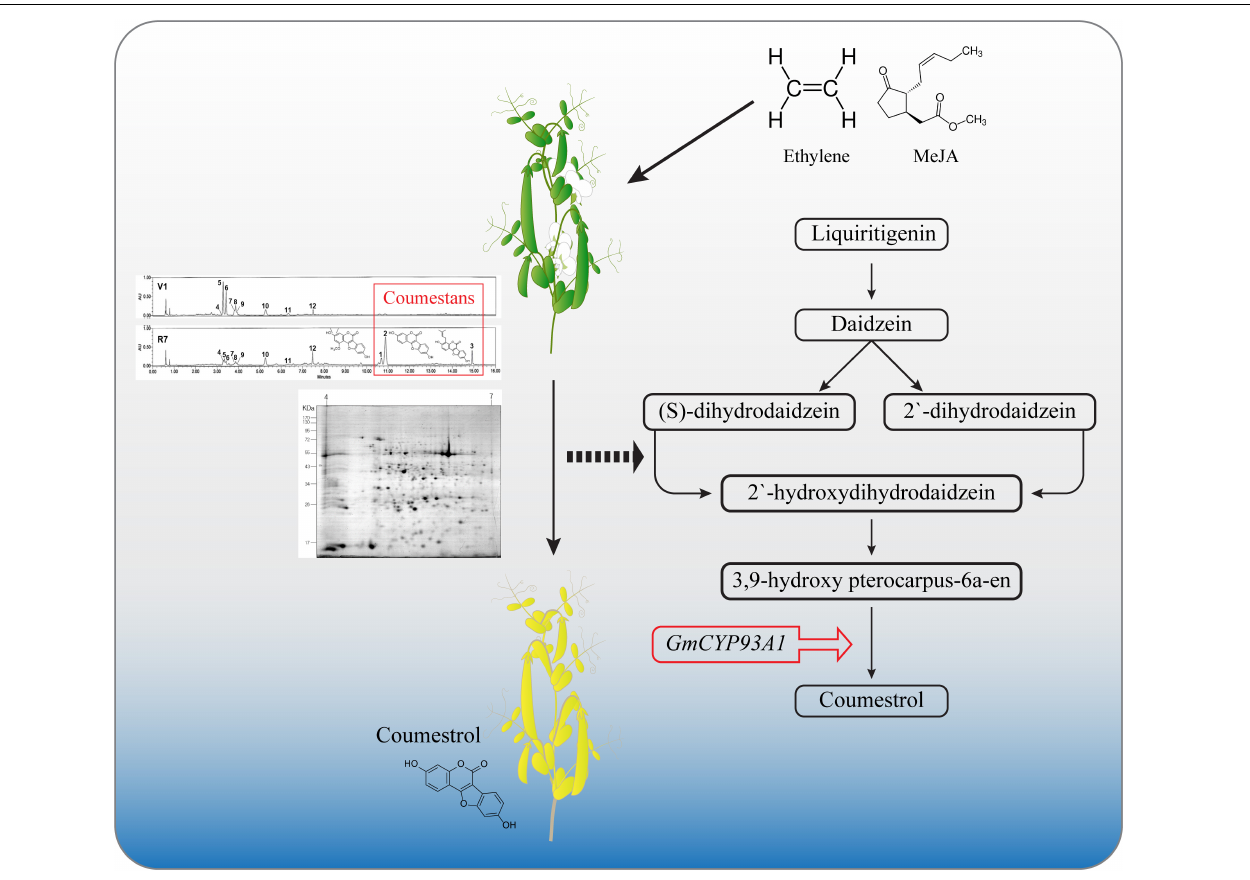
FIGURE 6 | Schematic diagram showing the role of coumestans in soybean senescence. Significantly higher accumulation proteins involved in regulating secondary metabolites, such as glutamine synthetase, 3,9 -dihydroxypterocarpan-6A-monooxygenase, and isoflavone reductase homolog 2 were detected in mature soybean leaves (R7 stage). The 3,9 -dihydroxypterocarpan 6A-monooxygenase encoded by CYP93A1, is an enzyme involved in the final step of coumestrol biosynthesis. The application of phytohormones alone and in different combinations significantly increased the expression of CYP93A1 . External application of 5 ppm coumestrol induced senescence in soybean leaves characterized by yellowing of the